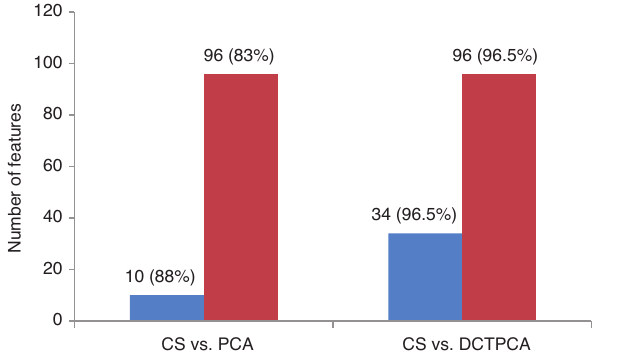
Figure 9: Graph Indicating the Comparative Recognition Rate for CS vs. PCA and CS vs. DCT-PCA for Various Numbers of